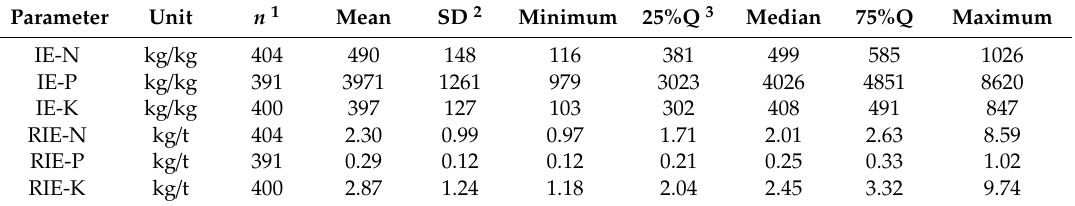
Table 5. Descriptive statistics of the internal efficiency of N, P, and K (IE, kg fruit per kg nutrient) and